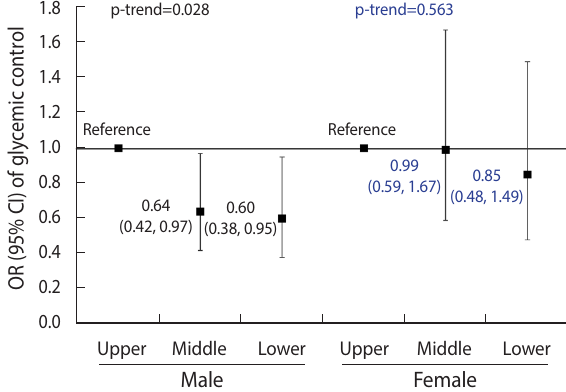
Figure 2. Subgroup analyses of the associations between grip strength and glycemic control in diabetes. Values are presented as OR (95% CI), adjusted for age, sex, education, house income, cur- rent smoking, alcohol intake, family history, obesity, hypertension, hypercholestrolemia, and insulin use. OR, odds ratio; CI, confidence